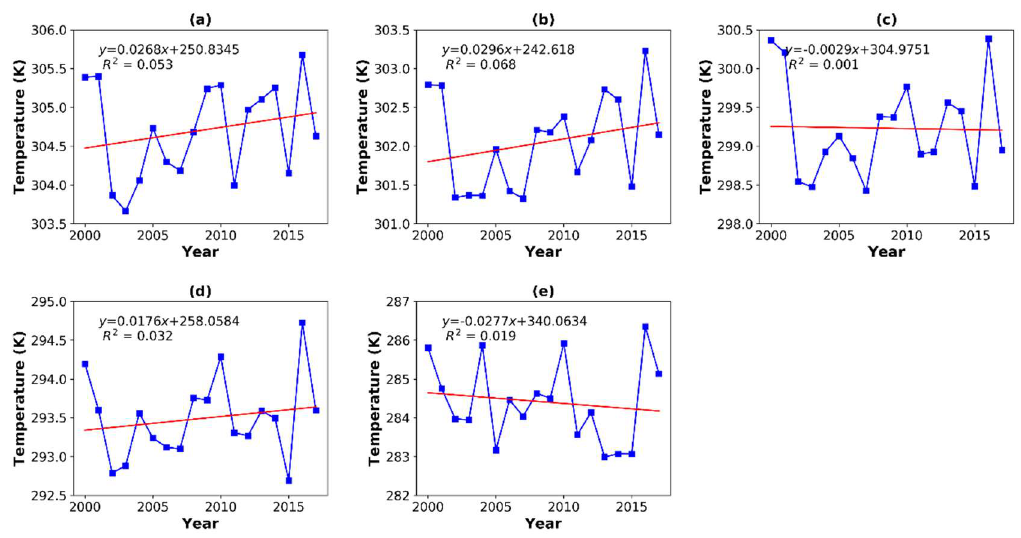
Figure 4. Temporal variation and linear trend of the average daytime MAST in the ( a ) Terai Plain, ( b ) Siwalik Hills, ( c ) Middle Mountains, ( d ) High Mountains, and ( e ) High Himalaya during the period from 2000 to 2017. (*Significant at a 95% confidence level).